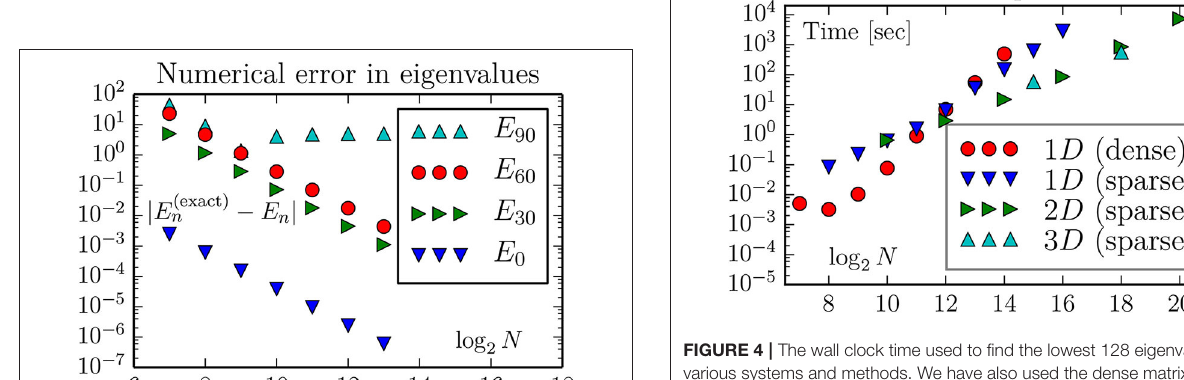
FIGURE 3 | The discretizations error computed by the routine eigsh from FIGURE 1 | The 128 lowest eigenvalues of Equation (15), computed with the scipy.sparse.linalg . For a fixed lattice size the discretizations error is standard 3-stensil approximation for the Laplace operator (here the kinetic essentially the same as with dense matrix routines. However, with a memory energy T ). The parameters are chosen to illustrate two typical effects: With the requirement proportional to the lattice size (instead of its square) it becomes bc =( a , a ) boundary conditions the harmonic oscillator potential is effectively possible to go to much larger lattices. This figure also demonstrates ( E 70 ) that changed to V for x 12.5, thereby modifying the behavior of extended = ∞ ≥ the error can be limited by boundary effects instead of the finite discretization (highly exited) states. The effect of this is to increase the eigenenergies of such length δ x . states, to a behavior more similar to a particle-in-box. This is visible for n & 80. The effect of using the 3-stensil approximation for T is to change the spectrum of this operator from k 2 to (the slower rising) (2 /δ x ) 2 sin 2 ( k δ x / 2). This is visible in the sub-linear rise of the spectrum for N 2 7 . =